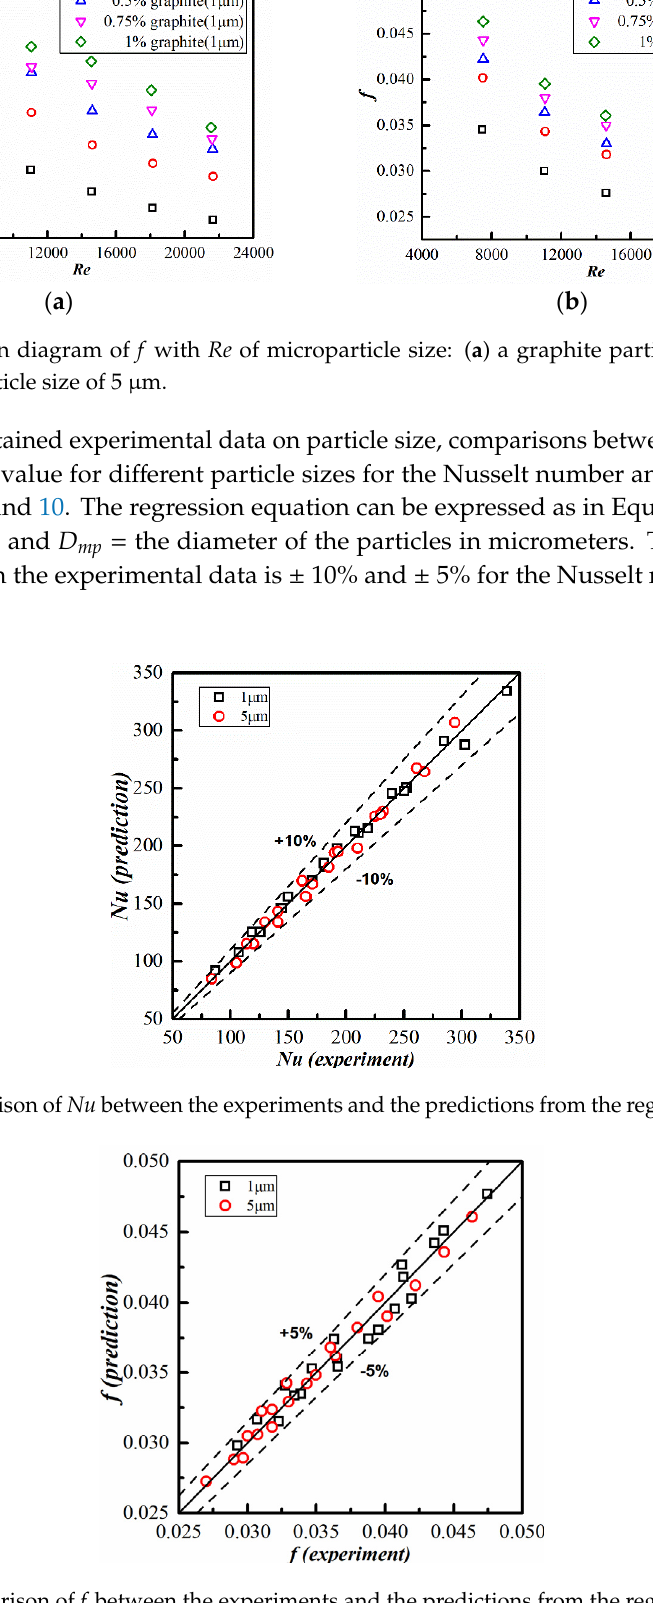
Figure 10. Comparison of f between the experiments and the predictions from the regression equation.